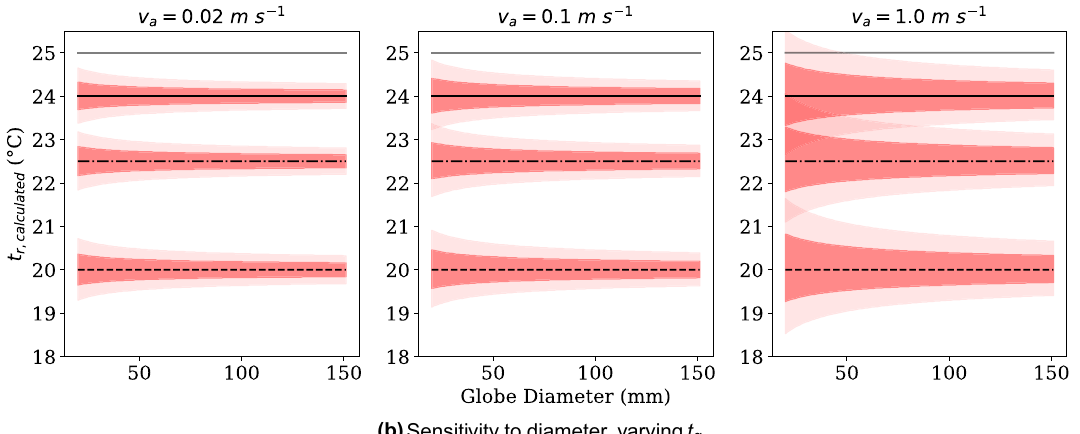
Figure 11. Discrete sensitivity analysis for different constant conditions for T g and D . In ( a ), air speed was varied by 2 to 2 standard deviations, based on our observed measurement range. t r and t a were fixed quantities, − and the resulting range of t g was back-calculated from our proposed mixed convection correction factor. This was done for three average air speeds, producing a narrow band of expected t g fluctuations. Figure ( b ), however, allows both t g and the coincident v a to vary as was observed in our measurements, from deviations again. The resulting t r value varies greatly, particularly at low air speeds. this demonstrates the importance of ensuring steady